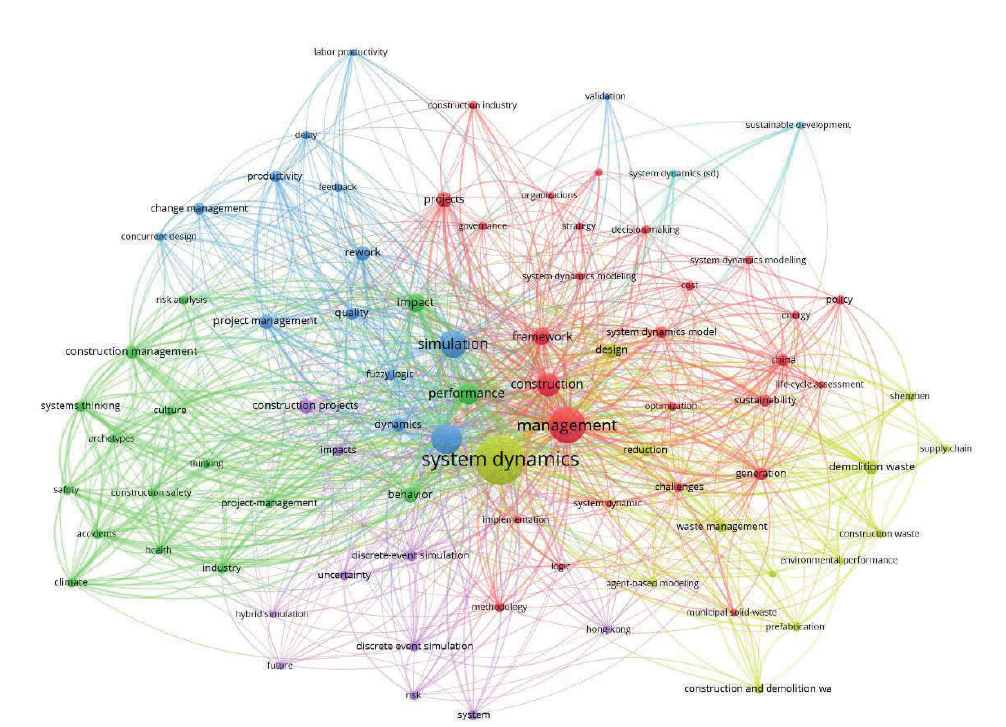
Fig. 8. Bibliometric map of all keywords. Source: created by the author with VOSviewer software, based on Clarivate analytics